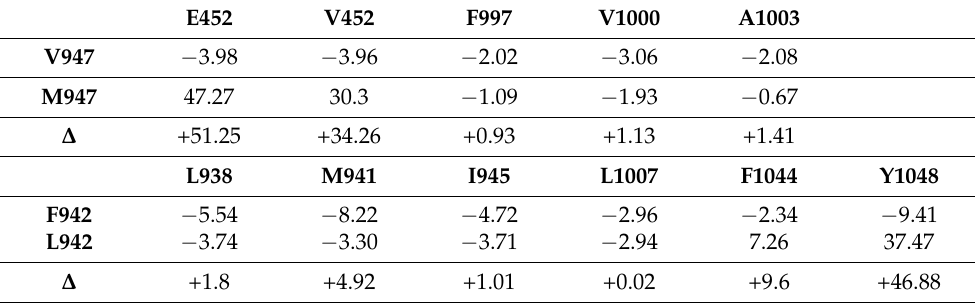
Table 2. Calculation of pairwise interaction energy (kJ/mol) between the side-chains of residues V947 (top) or F942 (bottom) (and their corresponding methionine and leucine mutants, respectively) and Yasara-calculated interacting residues. The values have been obtained with the Amino Acid Interactions (INTAA) web server using the WT or mutant rabbit Ca V 1.1 models, as indicated (PDB id: 5gjv). All residues interacting with V947 and F942 are conserved or semiconserved in human Ca V 2.1, except E452. Thus, V947 corresponds to V1396, F997 to Y1443, V1000 to V1446, A1003 to A1449 and E452 to V507 (the numbering of these Ca V 2.1 residues are referred to isoform 3). In the same way, F942 corresponds to F1394, L938 to F1390, M941 to I1393, I945 to V1397, L1007 to L1456, F1044 to F1493 and Y1048 to Y1497 (in this case, the numbering of the Ca V 2.1 amino acids are referred to isoform 2). As residue E452 is not conserved in human Ca V 2.1 (where the corresponding residue is a valine), we also evaluated how V947M mutation could affect the energy interaction with a valine at the same position (V452) by exchanging the sequence of the DII loop S1–S2 of rabbit Ca V 1.1 for that of human Ca V 2.1. E452 V452 F997 V1000 A1003